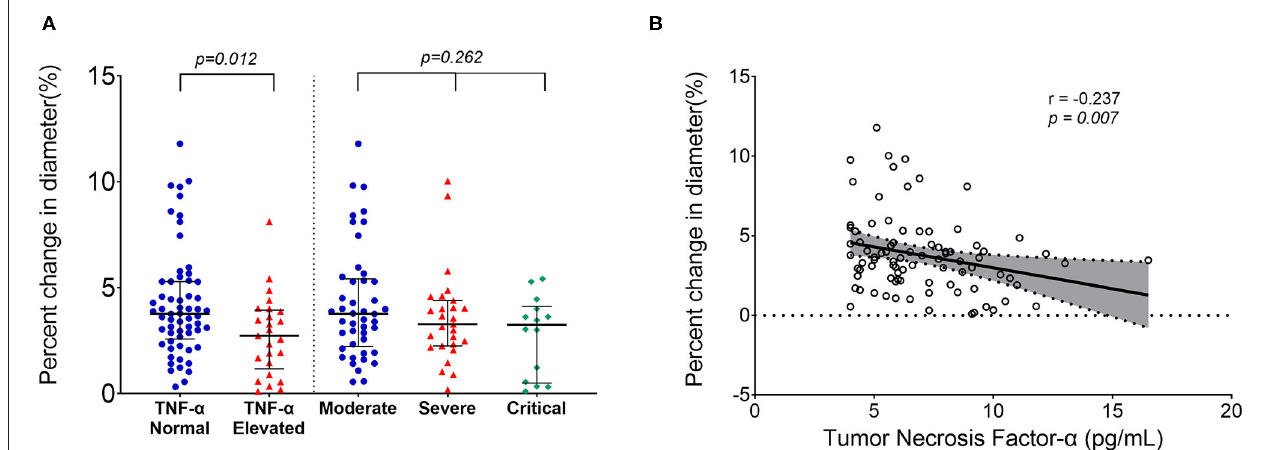
FIGURE 1 | Reduced endothelial function in survivors of COVID-19 late after recovery. No significant differences in brachial artery percent change in diameter existed among groups with different severity of the illness, but it was lower in patients with elevated tumor necrosis factor (TNF)- α than in patients without elevated TNF- α (A) . Correlation plots showing the inverse correlation between percent change in diameter and the serum TNF- α level (B) . Longer black lines indicate the median and shorter black lines indicate interquartile range in (A) . Each dot represents a value. Correlation plots display results from spearman correlation tests and a linear regression line with 95% confidence interval shading in (B)